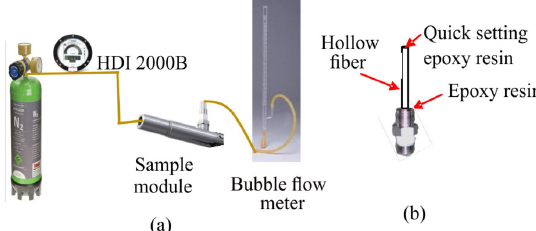
Fig. 2 Schematic diagram of apparatus for measuring gas permeation: (a) flow diagram; (b) permeation module.